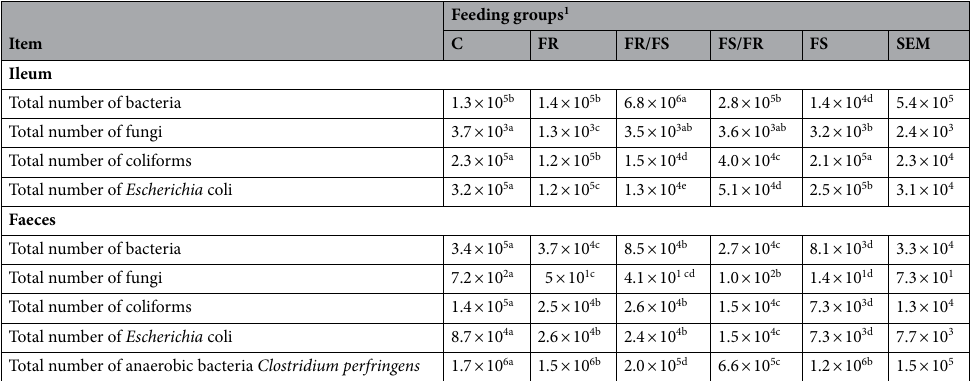
Table 4. Microbial composition (CFU/g) of the ileum and faeces of piglets. a,b,c,d Values in rows marked with different letters differ significantly at p ≤ 0.05. 1 Feeding groups: C—control; FR—group receiving a diet with 8% FRSM; FR/FS—group receiving a diet with 6% FRSM and 2% FSBM; FS/FR—group receiving a diet with 6% FSBM and 2% FRSM; FS—group receiving a diet with 8% FSBM.